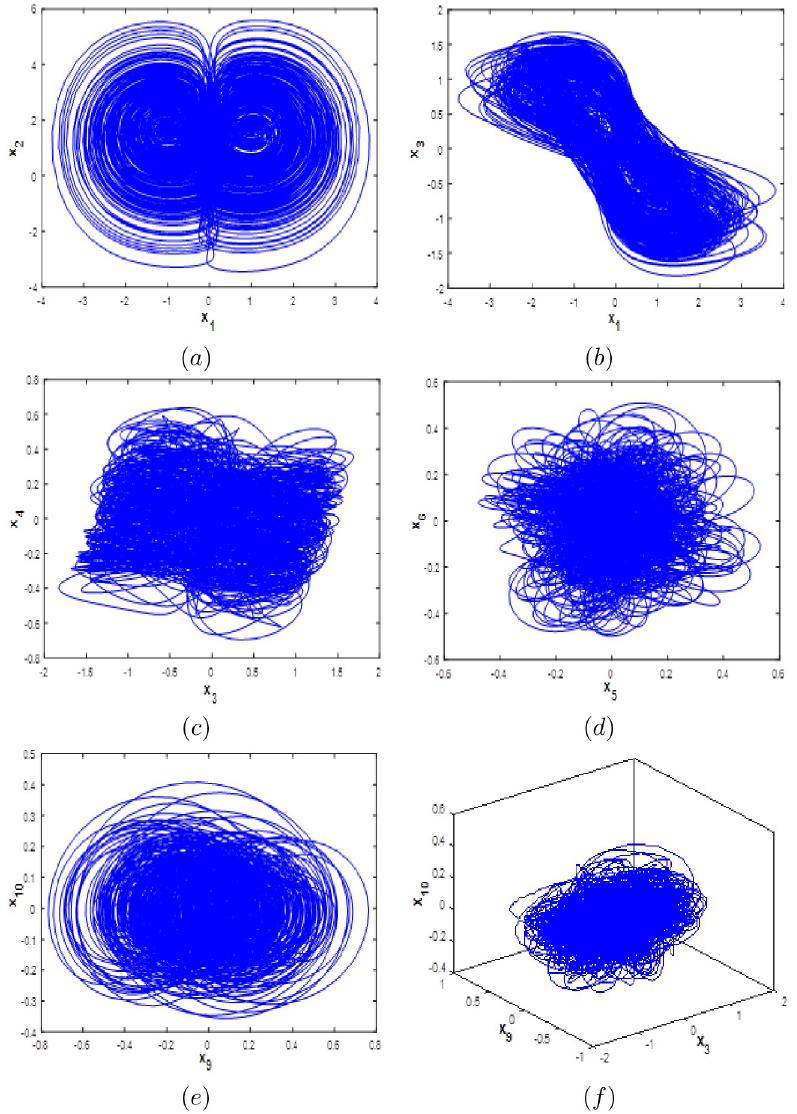
Fig 1. Phase portraits of the 10-D hyperchaotic system (1): (a) x 1 − x 2 attractor, (b) x 1 − x 3 attractor, (c) x 3 − x 4 , (d) x 5 − x 6 attractor, (e) x 9 − x 10 attractor and (f) x 3 − x 9 − x 10 attractor.